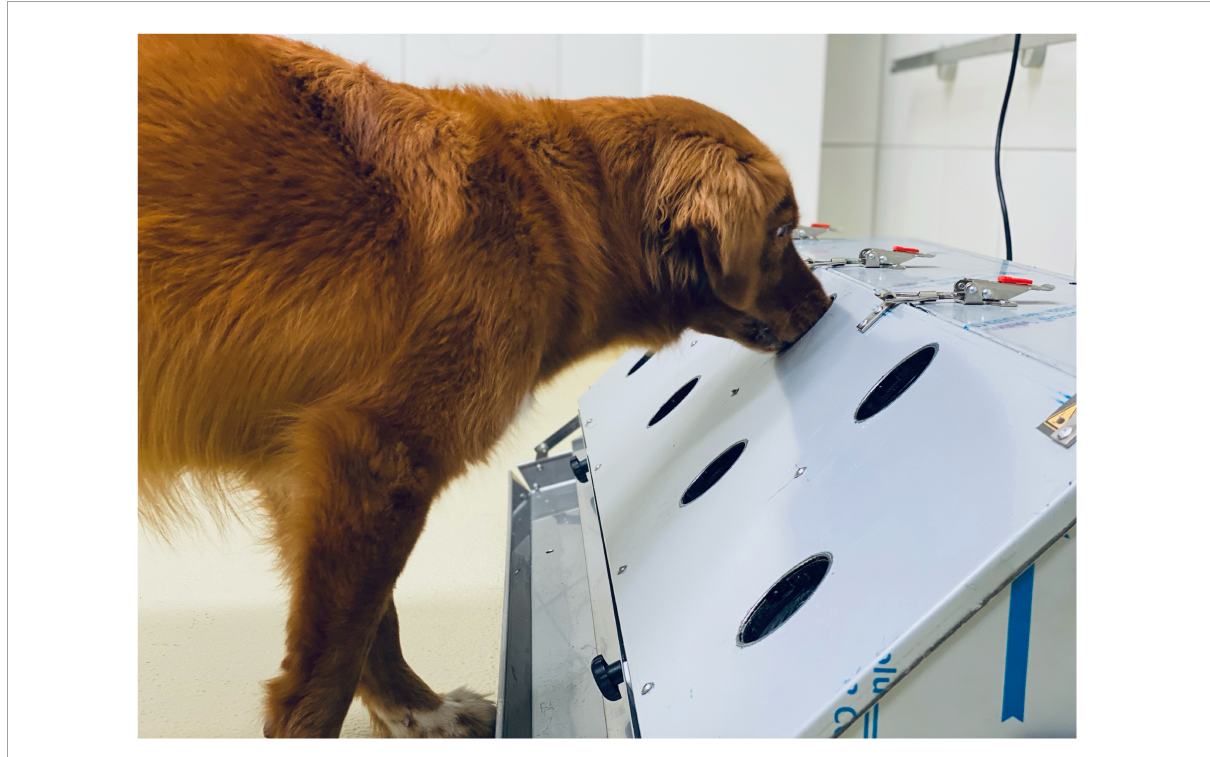
FIGURE4 Dog working at an automated detection dog training system